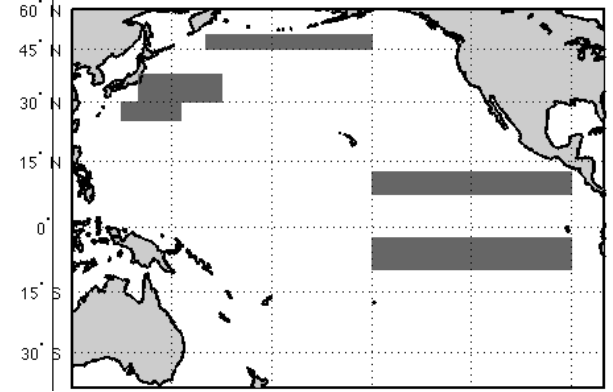
Fig. 12. Averaging areas as described in Table 1.